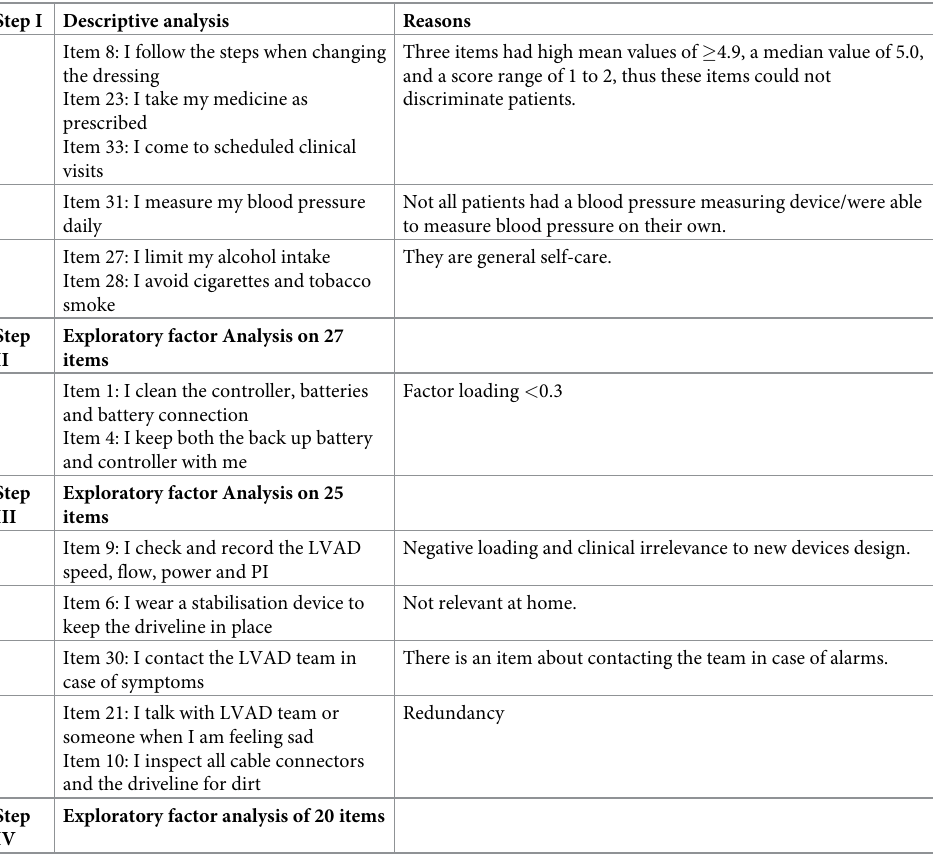
Table 3. Item reductions with